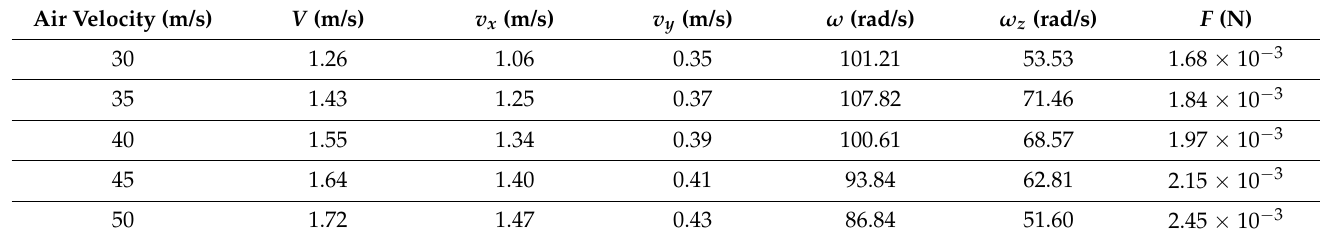
Table 3. E ff ects of di ff erent inlet air velocities on the motion characteristics of seeds in tubes. Table 3. Effects of different inlet air velocities on the motion characteristics of seeds in